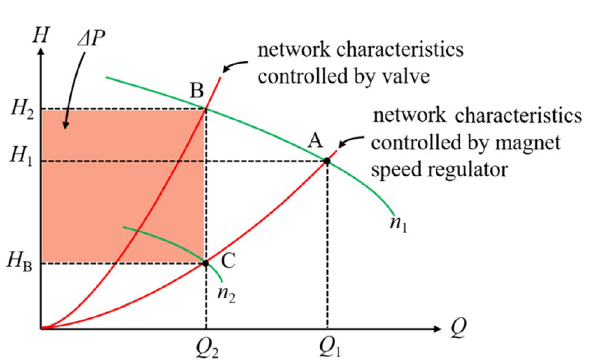
Figure 6. Different running